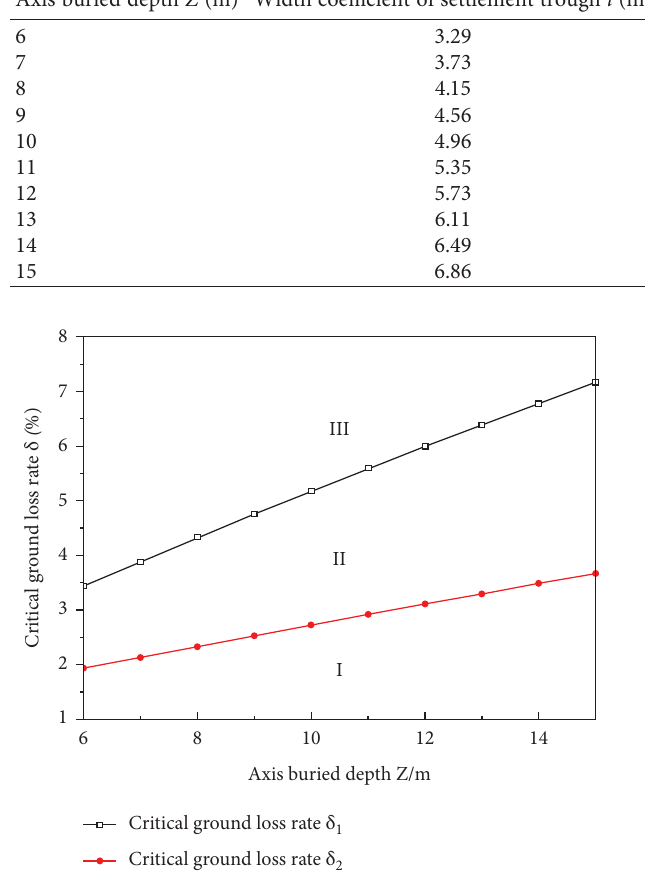
Figure 14: The critical ground loss ratio versus tunnel depth [24].